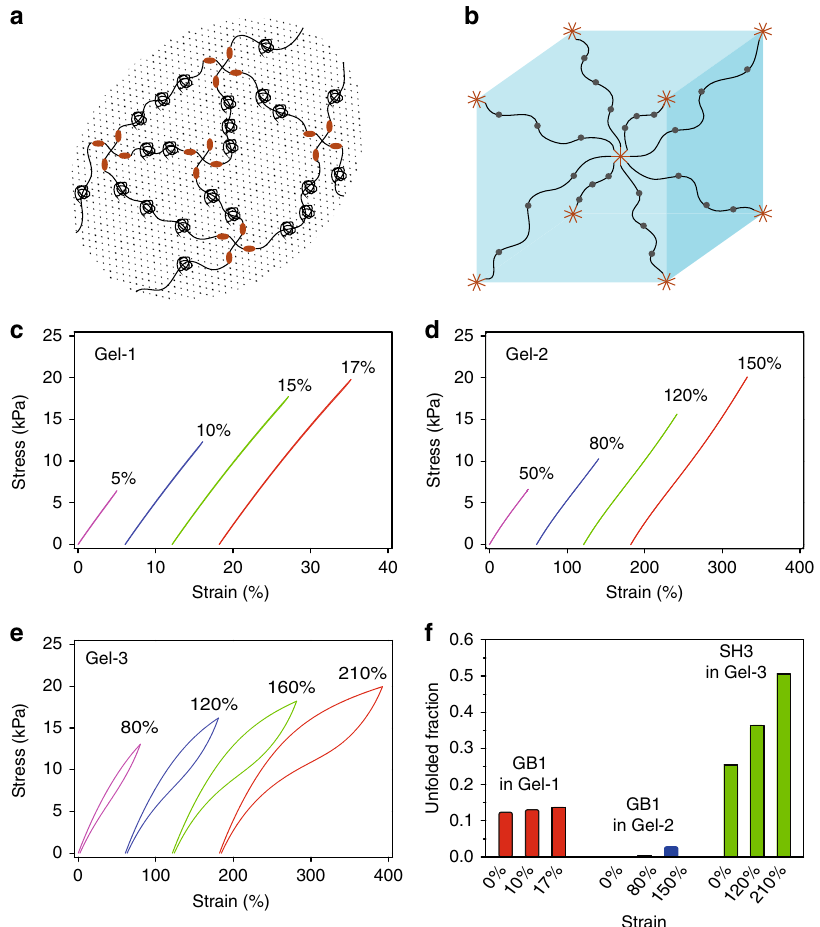
Fig. 4 Theoretical calculations of the mechanical response of the hydrogels. a Schematics of cross-linked protein gels with folded domains; b Representative volume element of a cube for gel elasticity. Within this cube, one protein chain extending out from each corner is cross-linked to one arm of the linker proteins extending from the cubic center. c – e Prediction of stress – strain curves for Gel-1 ( c ), Gel-2 ( d ), and Gel-3 ( e ) upon uniaxial loading and unloading cycles. Only Gel-3 is shown to dissipate a large amount of energy within loading cycles; ( f ) Prediction of unfolded fractions of folded domains within different gels upon uniaxial